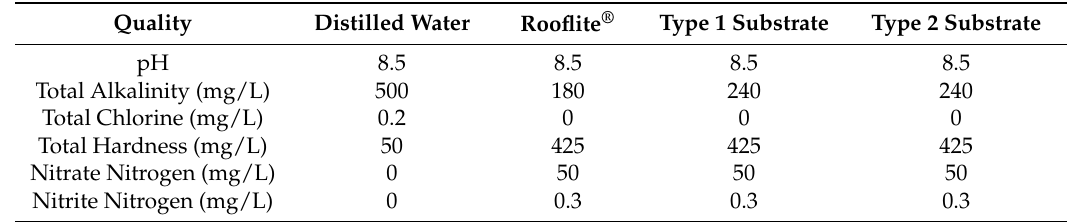
Table 3. Leachate quality assessment of all three substrates (Rooflite ® , Type 1 and Type 2).